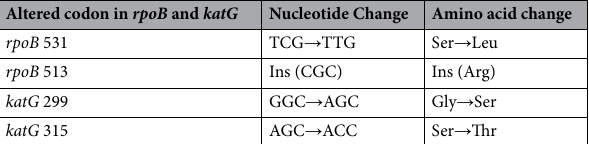
Table 2. DNA sequencing data for rpoB mutations in MDR M. tuberculosis strains from Pakistan.